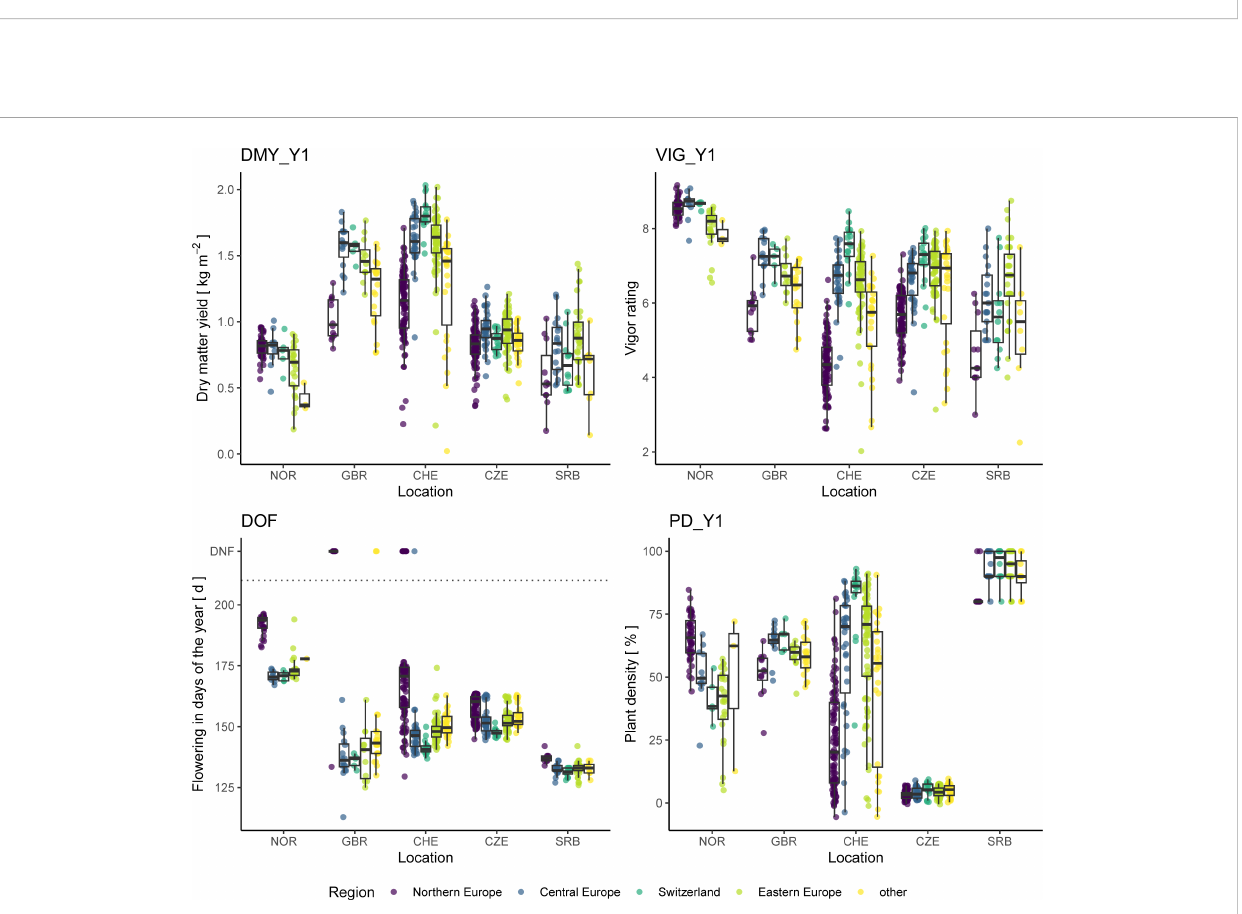
FIGURE 9 Performance of red clover accessions of the type ‘ cultivar ’ or ‘ breeding material ’ grouped by their region of origin. Traits analyzed are total dry matter yield of the fi rst year (DMY_Y1), average vigor of the fi rst year (VIG_Y1), date of fl owering (DOF) as well as plant density after the fi rst year (PD_Y1). In the plot of DOF, accessions that did not fl ower are displayed with a value of 222 and are labelled accordingly (DNF).